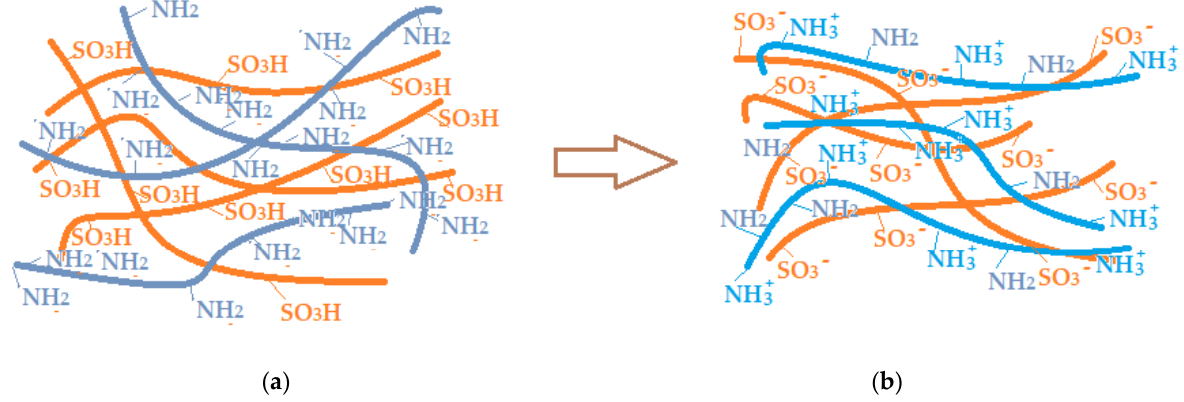
Figure 16. Schematic representation of the polymer mixture: before ( a ) and after ( b ) the formation of the chitosan – sulfonated ethylene-propylene-diene terpolymer membrane (Chi-sEPDM)